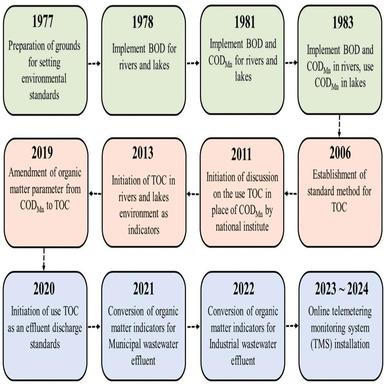
Chronological history of organic matter guidelines in South Korea.